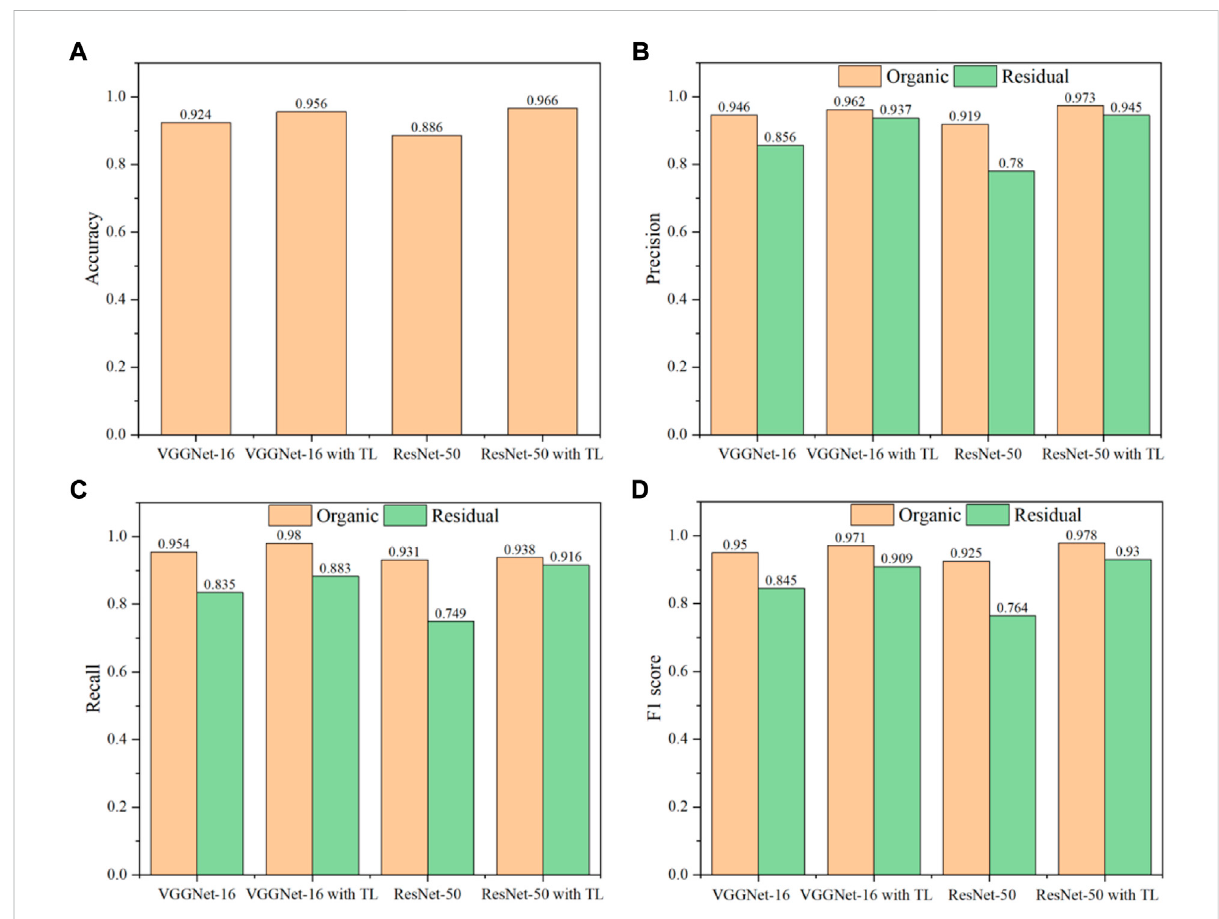
FIGURE 7 Effect of transfer learning on the performance of VGGNet-16 and ResNet-50: (A) Accuracy; (B) Precision; (C) Recall; (D) F1